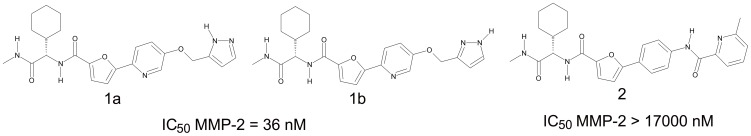
Structures and IC50 values of the studied ligands 1a, 1b and 2.